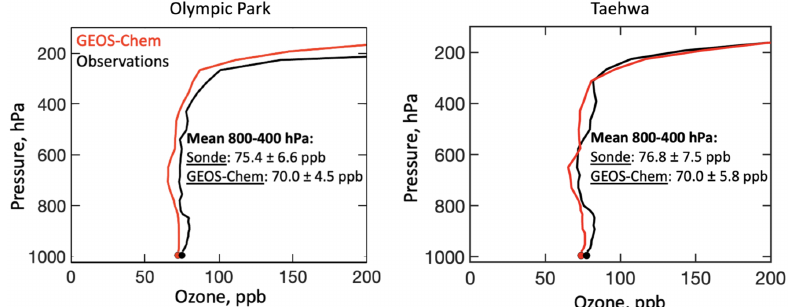
Figure 9. Mean vertical ozone profile over Olympic Park (37.522 ◦ N, 127.124 ◦ E) and Taehwa Research Forest (37.312 ◦ N, 127.310 ◦ E) in Seoul during KORUS-AQ (May–June 2016). Observations from Olympic Park and Taehwa are from 15 and 42 ozonesondes, respectively. Ozonesondes were launched between 13:00 and 14:00 local time on KORUS-AQ flight days. GEOS-Chem model results are sampled at the observation times. The circles show the surface ozone concentrations from GEOS-Chem and the AirKorea site in the closest proximity.